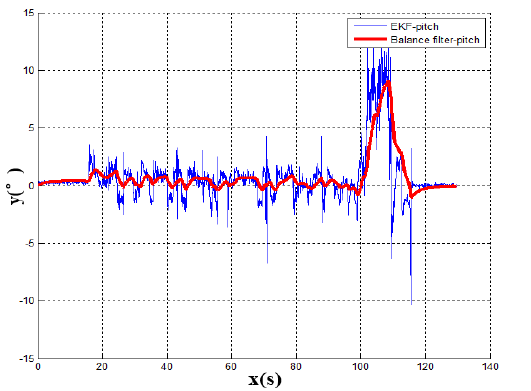
Figure 10. Experiment 4 pitch angle waveform diagram.